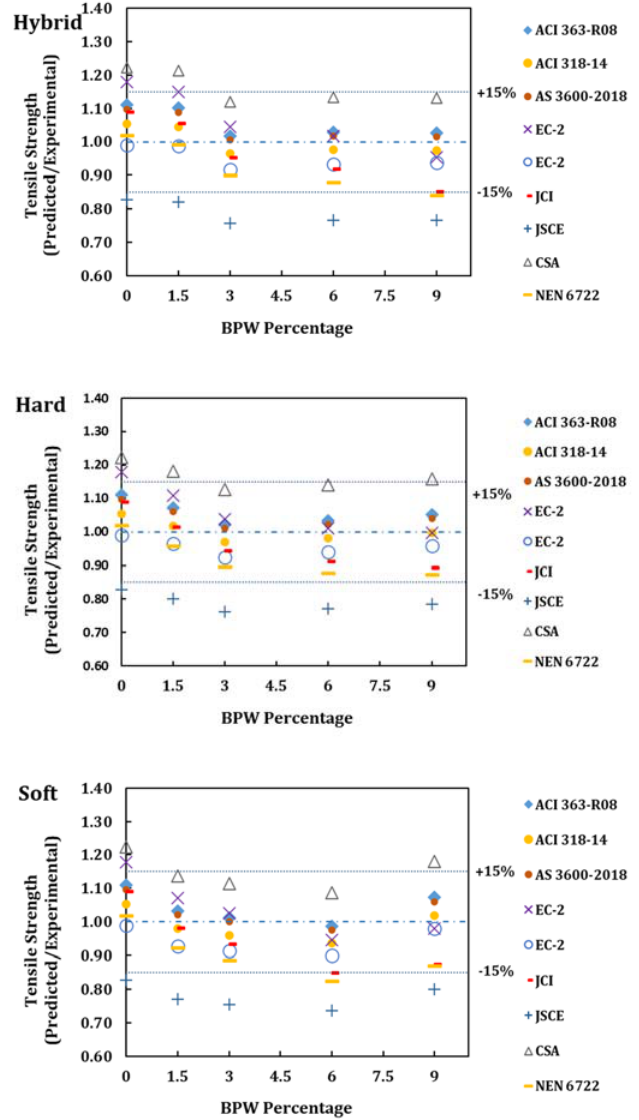
Figure 12. The ratio of predicted tensile strength from different standards for conventional concrete and experimental tensile strength results [16,68–77].